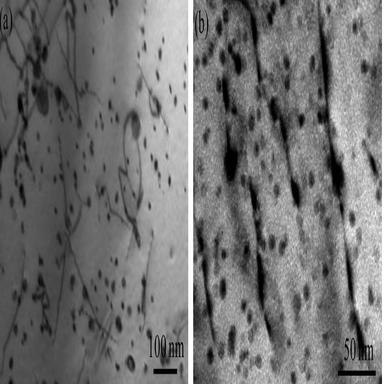
Microstructure of the novel carbide-free 9Cr-ODS steel after tempered at 750 ℃ by TEM in a relatively high magnification: (a) interaction between the dislocations and nano-size yttrium oxides, and (b) morphology and distribution of nano-size yttrium oxides.